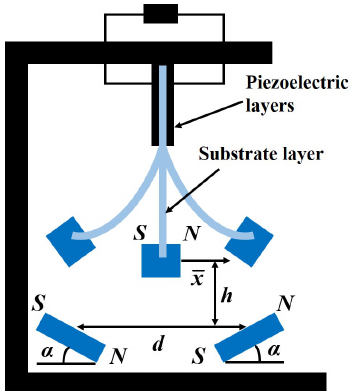
Figure 1. Schematics of a general piezoelectric energy harvester